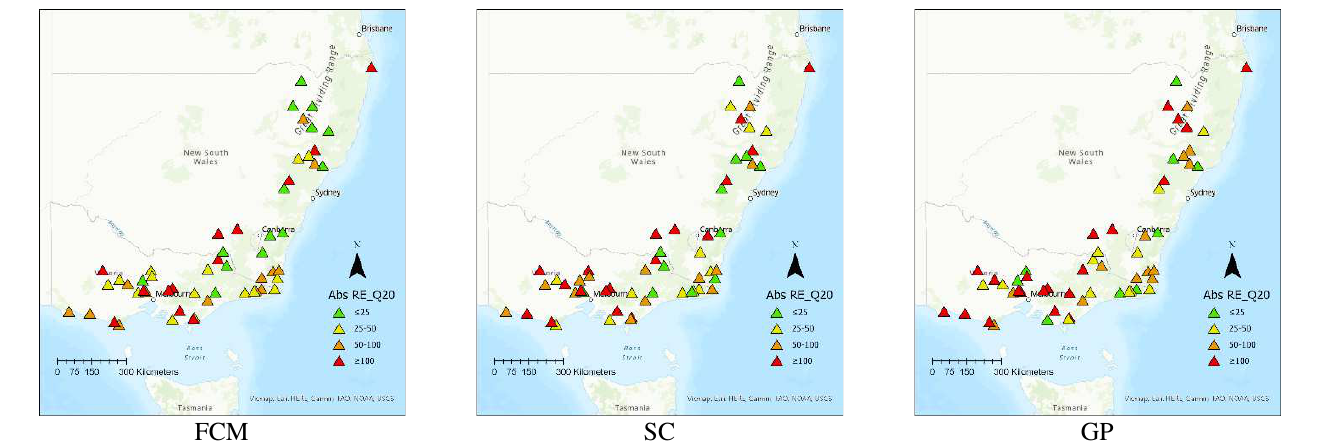
Figure 8. Spatial distribution of REr values for Q20 for FCM, SC, and GP models.